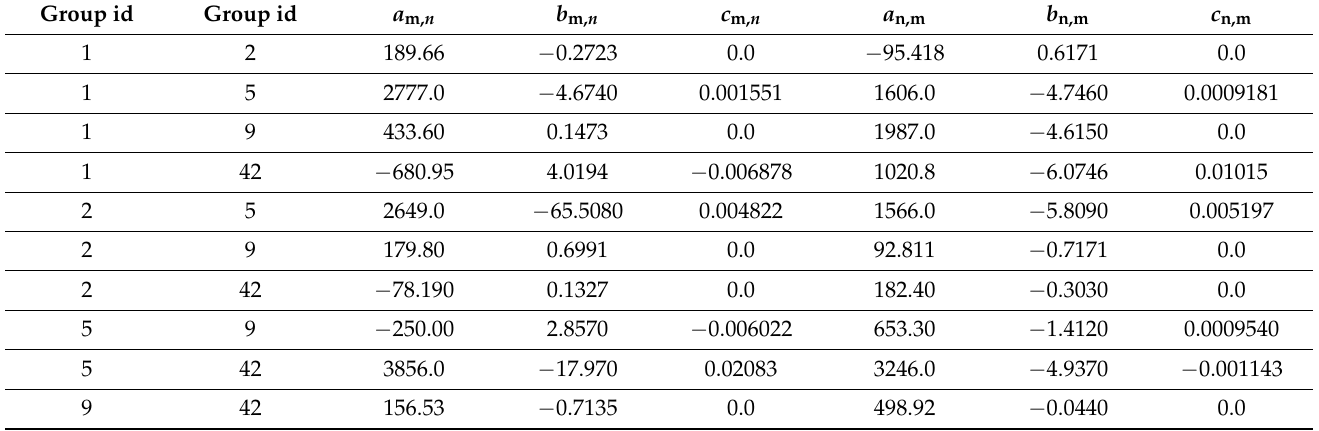
Table A4. UNIFAC group binary interaction parameters [5].